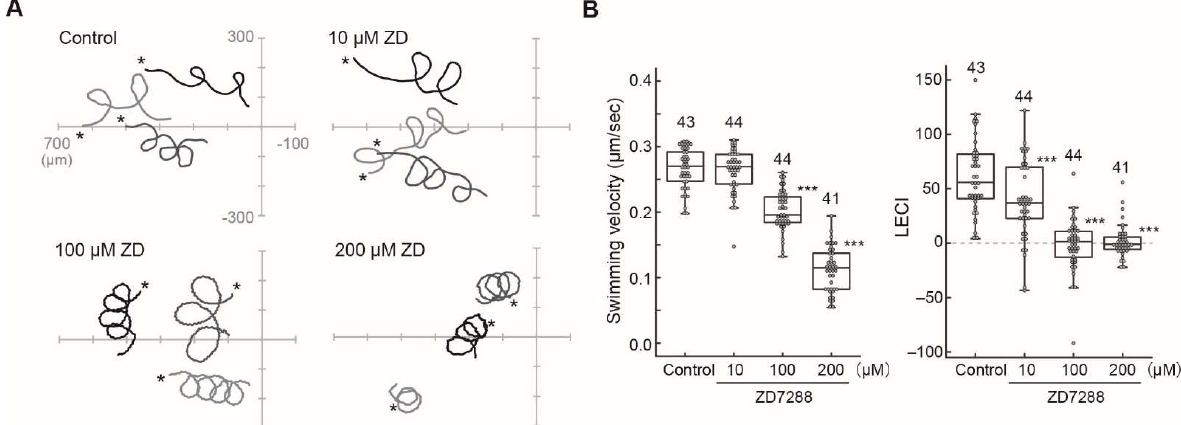
Figure 6. Effects of a HCN channel inhibitor ZD7288 on the chemotaxis of Ciona sperm. ( A ) Sperm swimming trajectories of four representative sperm in the presence of several concentrations of ZD7288 are shown. * The asterisks show the starting points of sperm swimming trajectory. ( B ) Comparison of sperm swimming velocity (Left) and linear equation chemotaxis indices (LECI) (Right) in control and inhibitor-treated sperm. Distribution of values is plotted in a box plot. Total number of observed spermatozoa from three experiments is shown on the top of each bar. *** Significant at p < 0.001 (Dunnett’s test) as compared with the control.